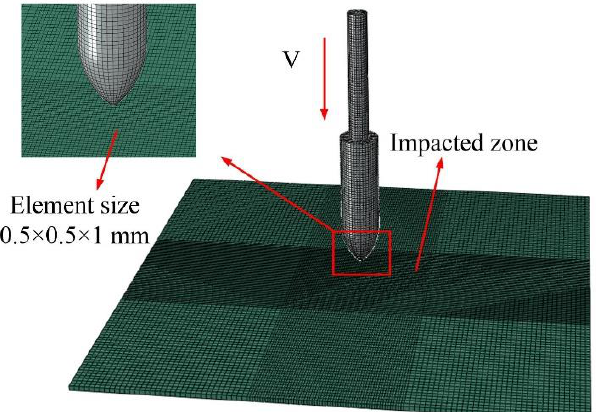
Figure 3. Harpoon penetration simulation.